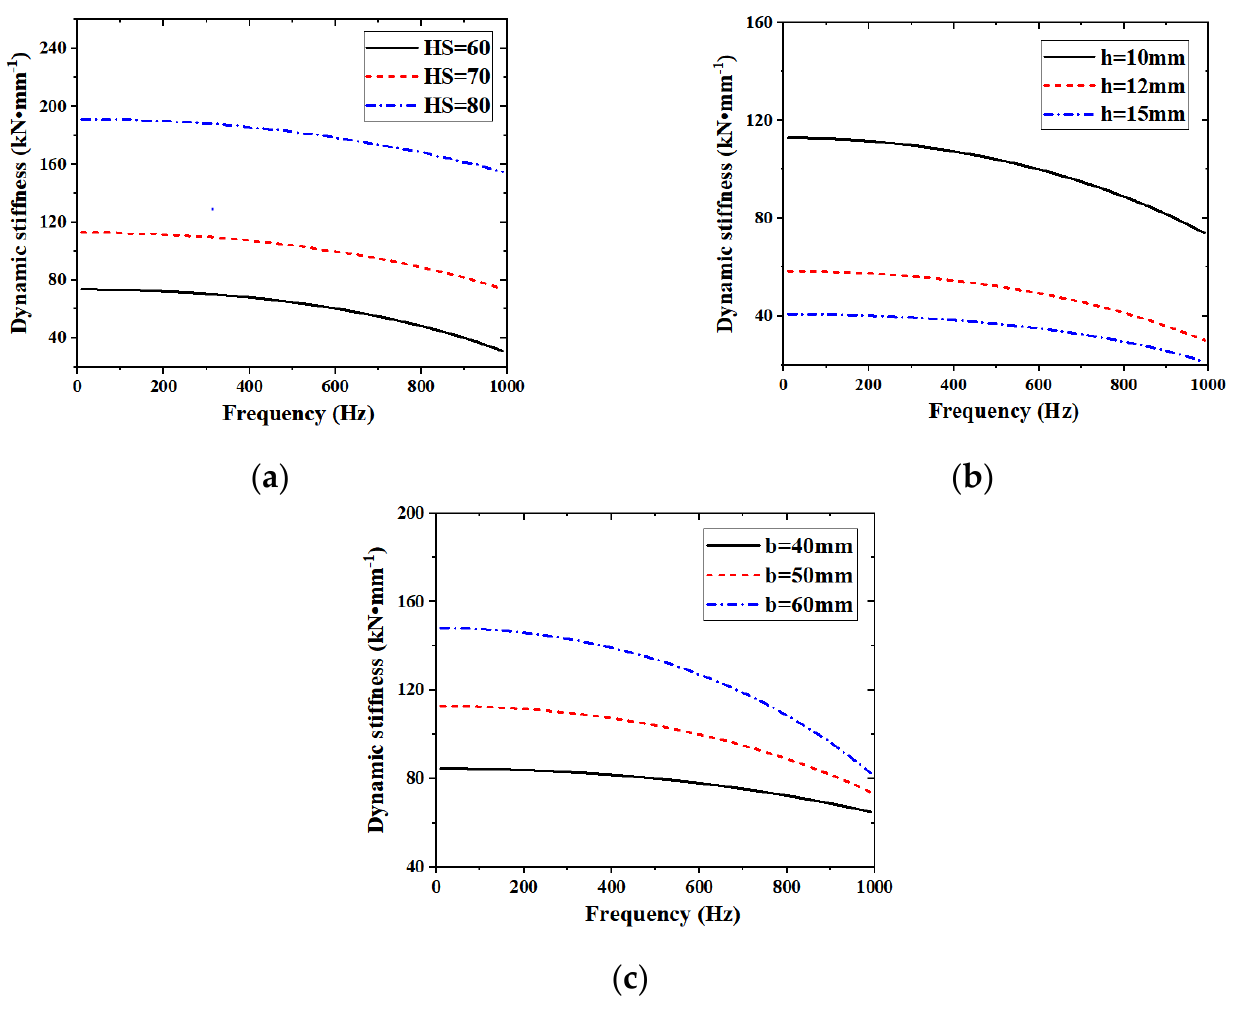
Figure 12. The dynamic stiffness of the first-stage vibration isolator with ( a ) different material hardnesses, ( b ) different ring thicknesses, and ( c ) different ring